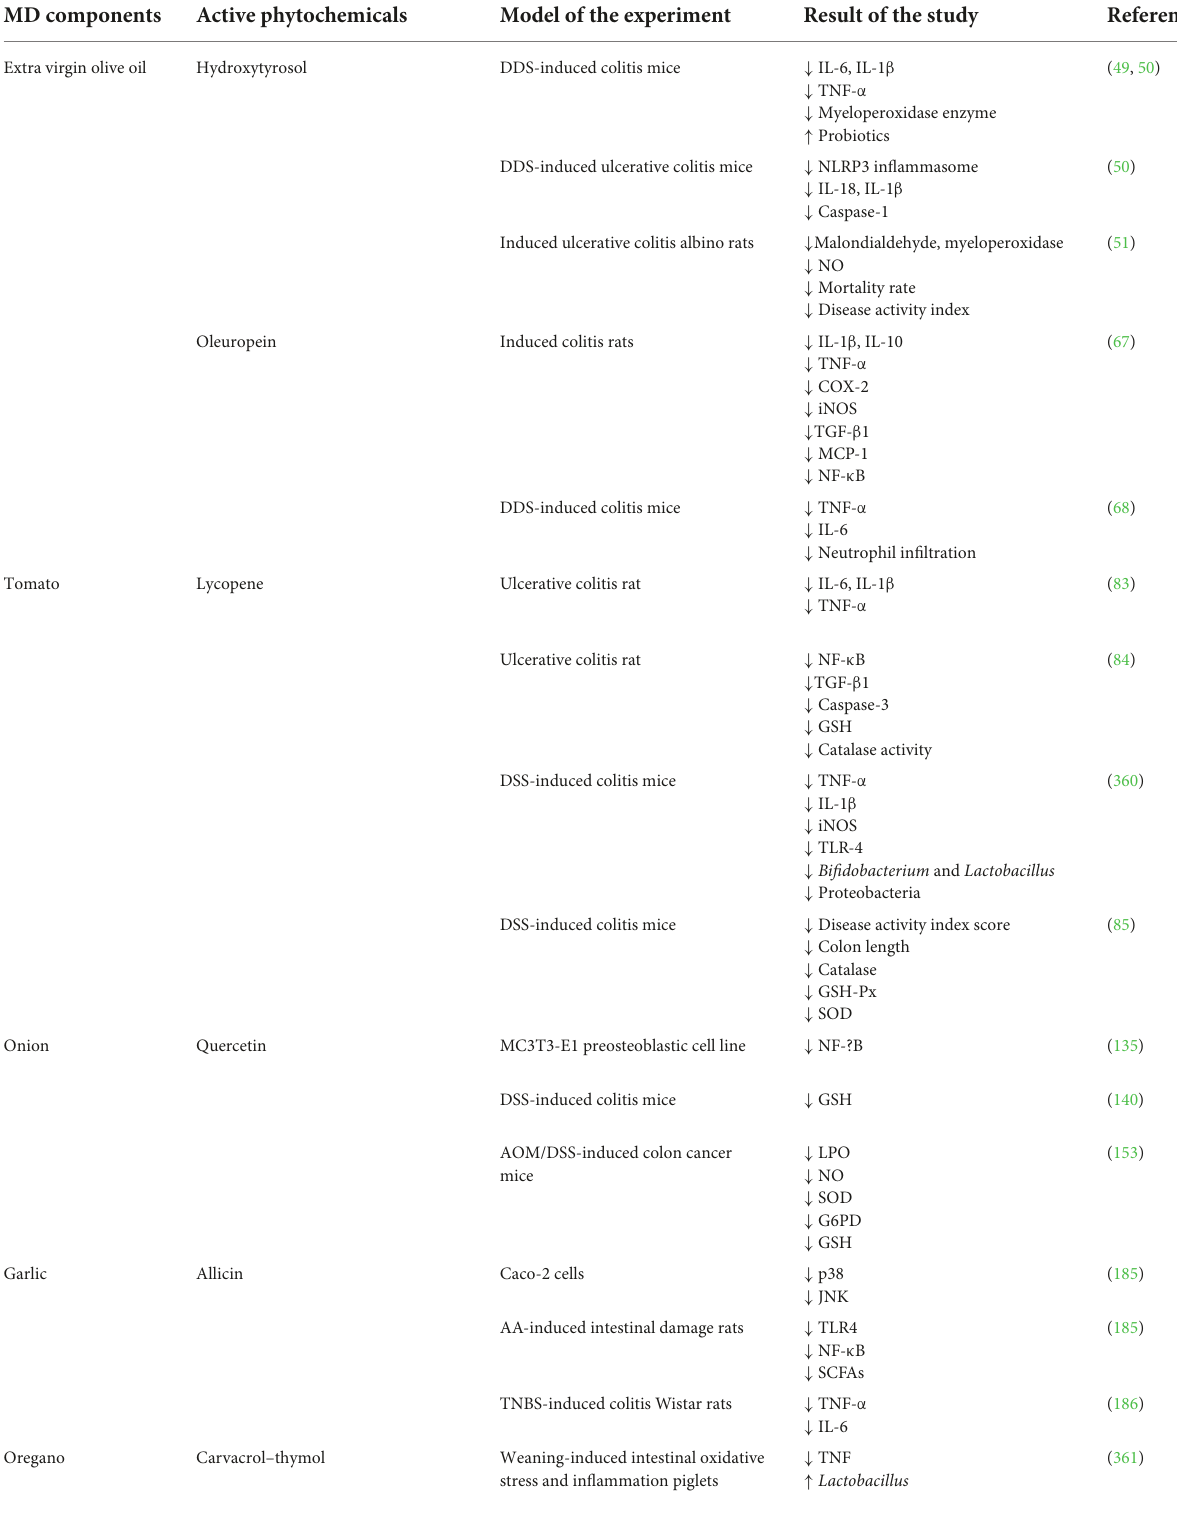
TABLE 1 Anti-inflammatory effects of the main Mediterranean diet